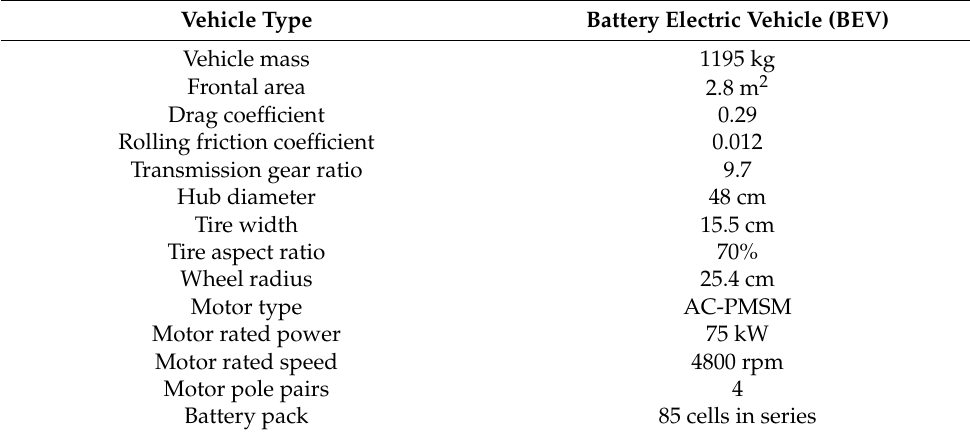
Table 3. Electric Vehicle technical specifications extrapolated from Technical specifications of BMWi3 model [26].